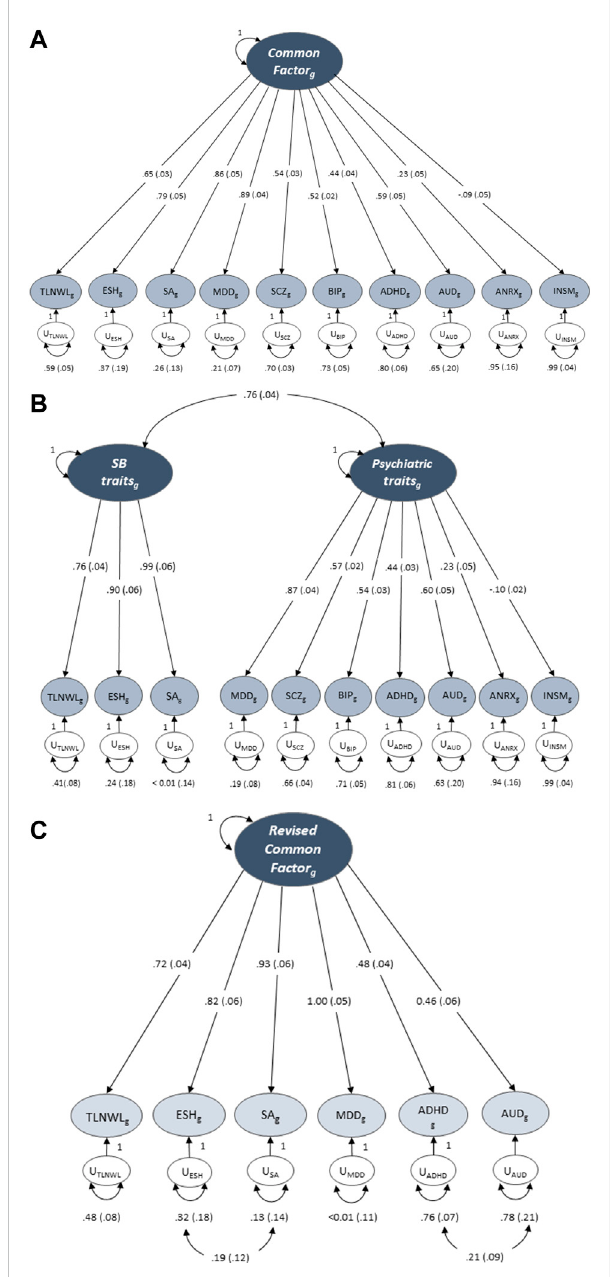
FIGURE 2 Genomicstructuralequationmodelsofthestandardisedsolutionsof the SB and psychiatric traits. (A) Displays the path diagram (with standard errors in parenthesis) for the common factor model where there is only one factor that depicts the overarching common variance between all included traits. (B) Displays a two-factor model with three SB traits loadedontothelatentsuicidalbehaviourfactorandsevenpsychiatrictraits loaded onto a psychiatric latent factor. (C) Displays the path diagram for the revised common factor model which shows the factor loadings for traits that displayed a loading ≥ 0.40 at EFA. SCZ, BIP, ANRX and INSM did not meet the factor loading